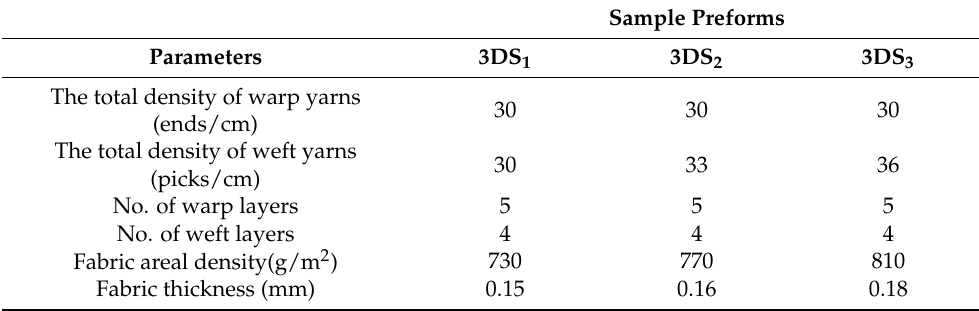
Table 1. Specific parameters of 3DPPAI Kevlar fabric.